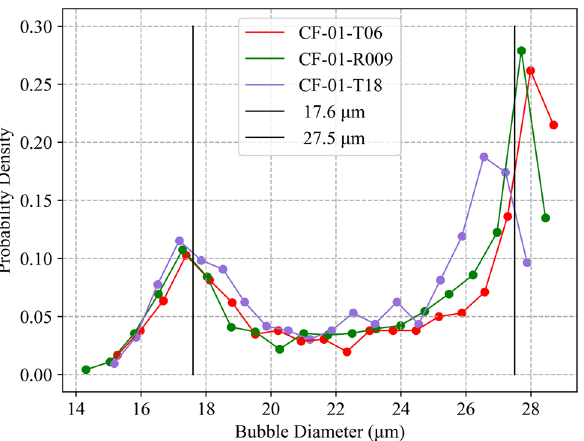
Figure 6. Apparent bi-modal void diameter distribution within the simulated particles comparable to CF-01-R009, CF-01-T18 and CF-01-T06 with respective diameters of 406.5 μm, 336.5 μm and 384.5 μm. The observed distribution was obtained using an initial pressure of 0.55 MPa and an initial temperature of 1900 K and shows peaks centred around 17.6 μm and 27.5 μm, respectively.